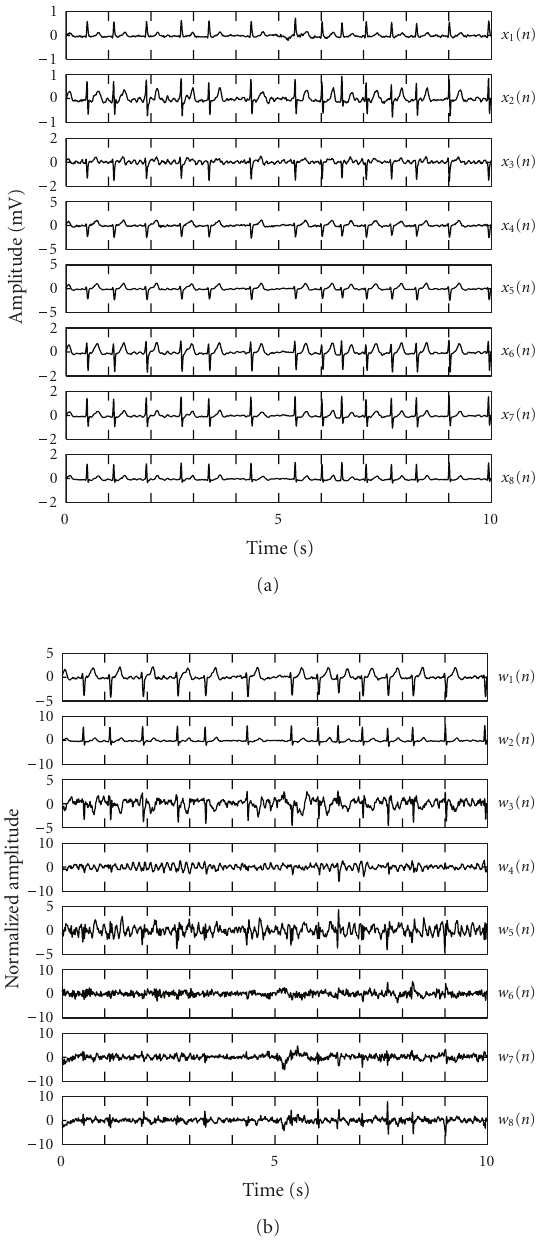
Figure 12: Example of atrial signal extraction during AF using a multilead PCA approach. (a) The original 8 ECG leads, where x 1 and x 2 are I and II limb leads, and x 3 to x 8 are the precordial leads, and (b) the corresponding principal